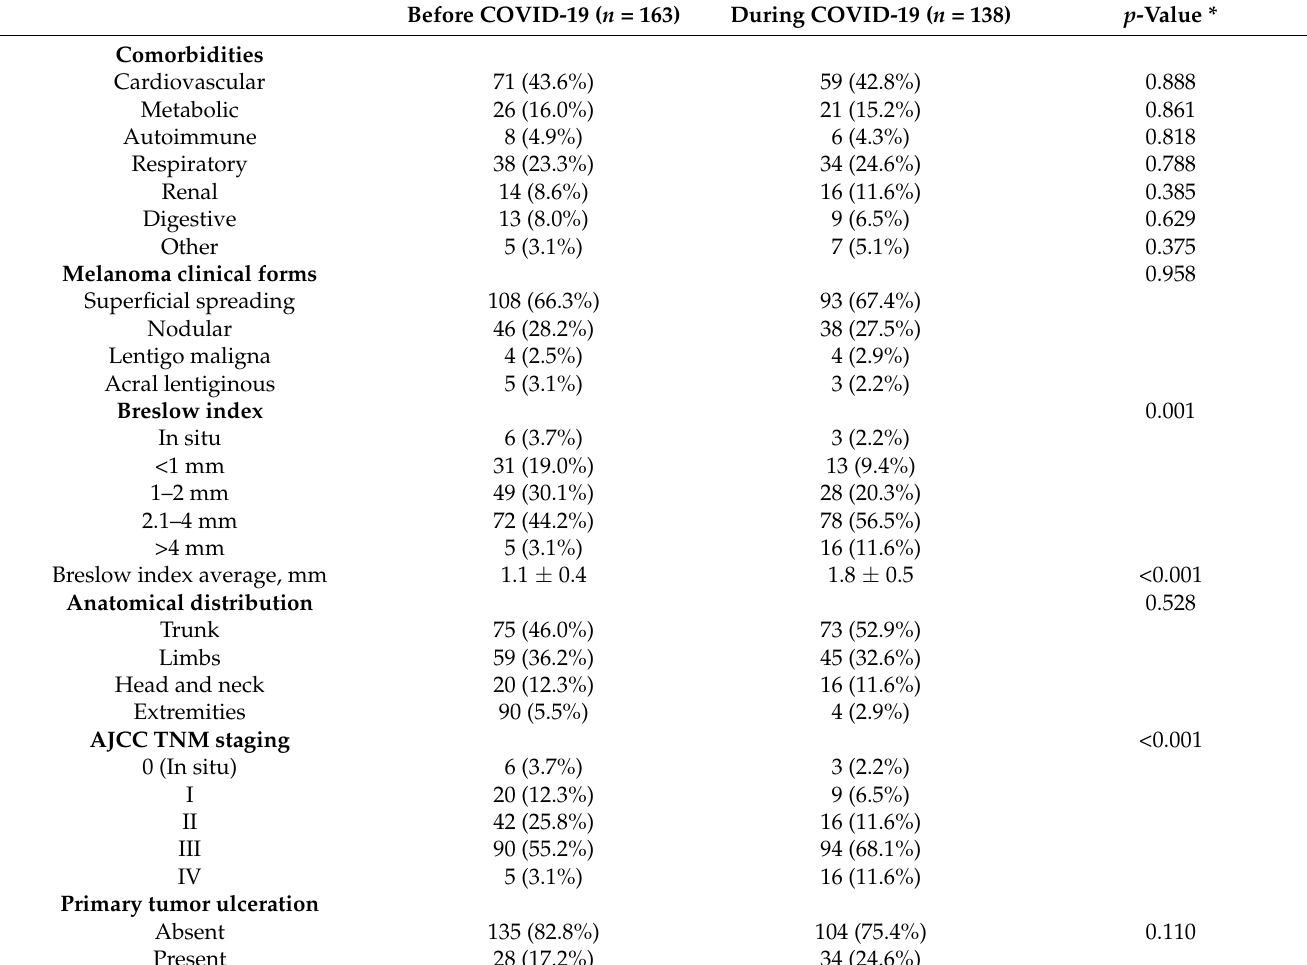
Table 2. Malignant melanoma characteristics of patients before and during the COVID-19 pandemic. Before COVID-19 ( n = 163) During COVID-19 ( n = 138) p -Value